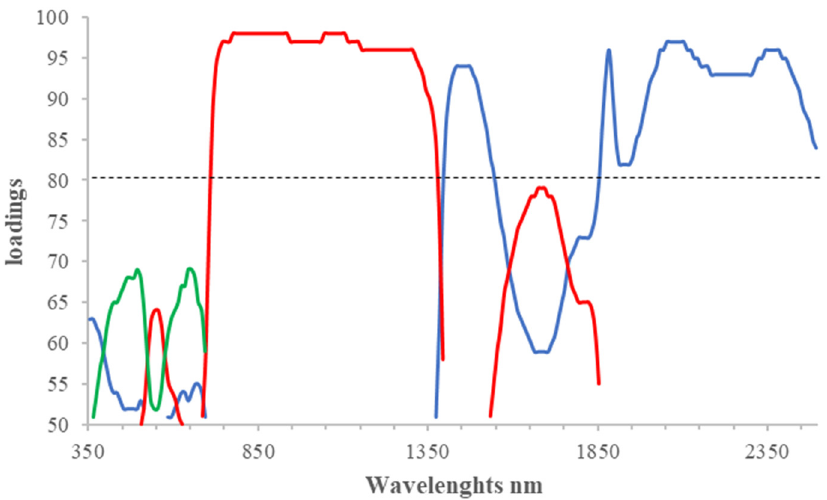
Figure 1. Graph of the loadings of the first PC1 (blue line), the second PC2 (red line), and the third PC3 (green line) >80. The dashed line represents the chosen threshold for loading values.